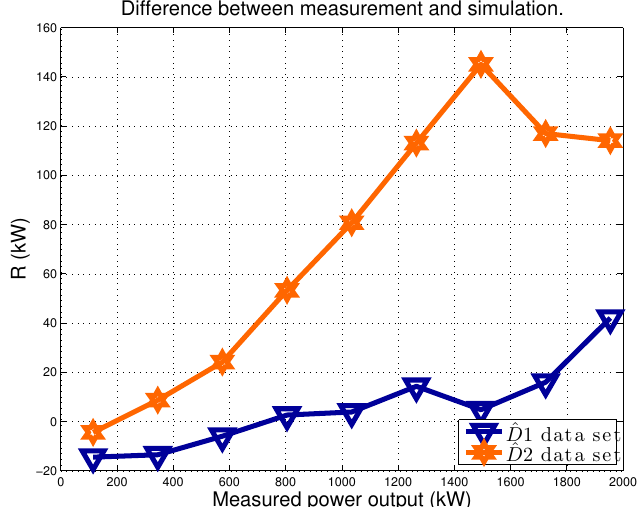
Figure 4. The average difference R between power measurement y and estimation ˆ y (Equation (4)). Data sets: D1 and D2. Sample run of the